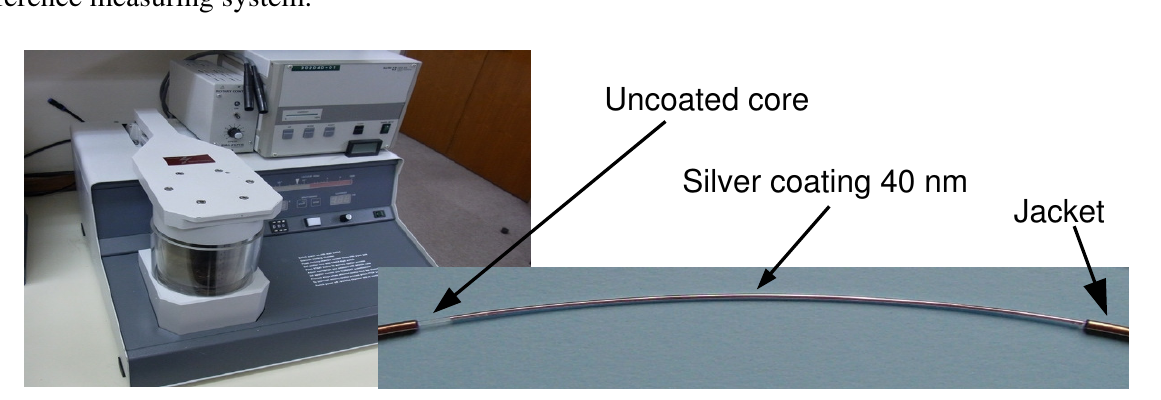
Figure 5. DC sputter used for the deposition ( left ) and an example of a fiber coated with 40 nm of silver ( right ).